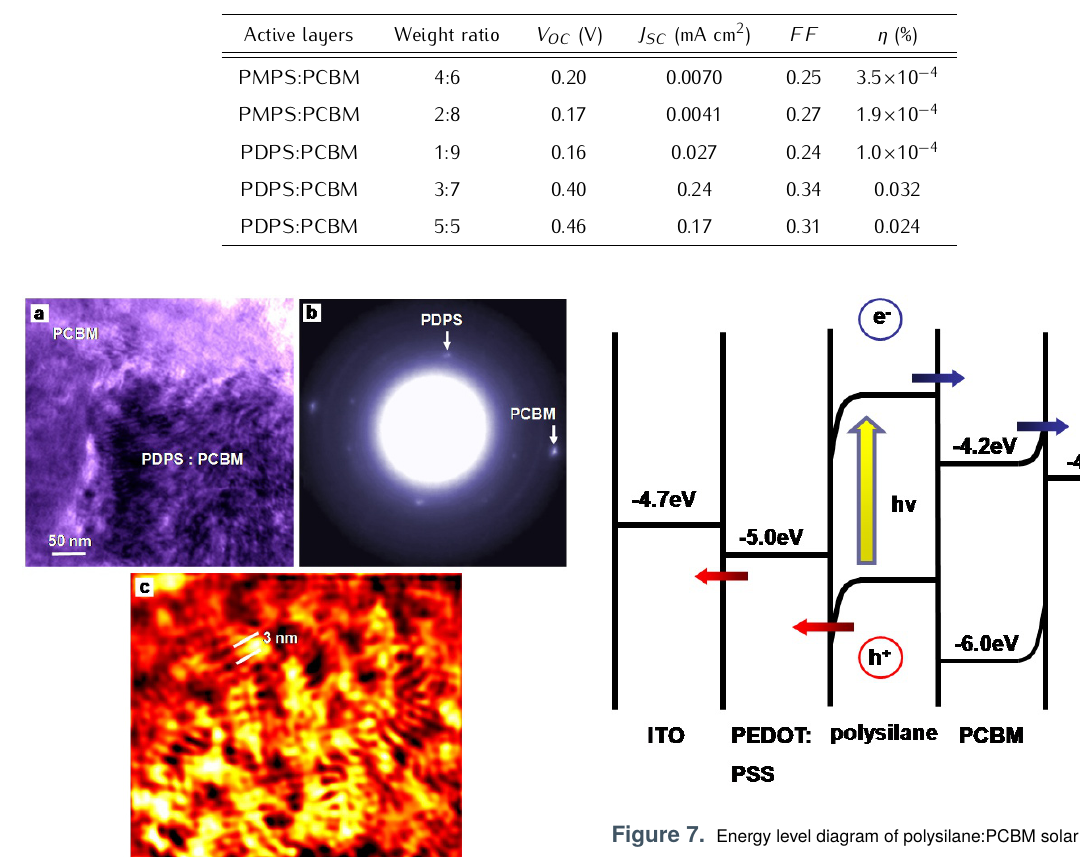
Figure 6. (a) TEM image, (b) electron diffraction pattern and (c) HREM image of PDPS:PCBM thin films